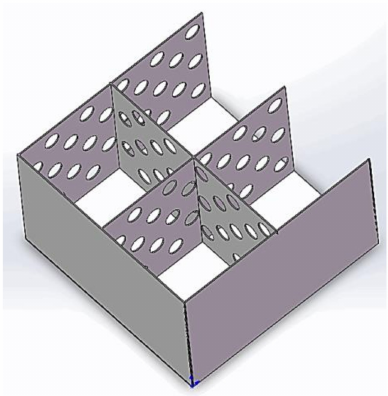
Figure 3. Partial enlarged view of multi cavity steel plate.